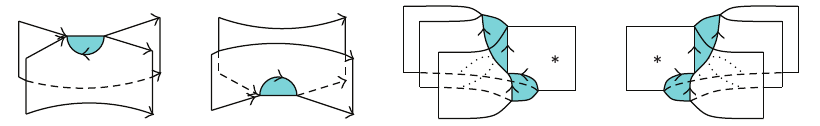
Figure 1: Some elementary